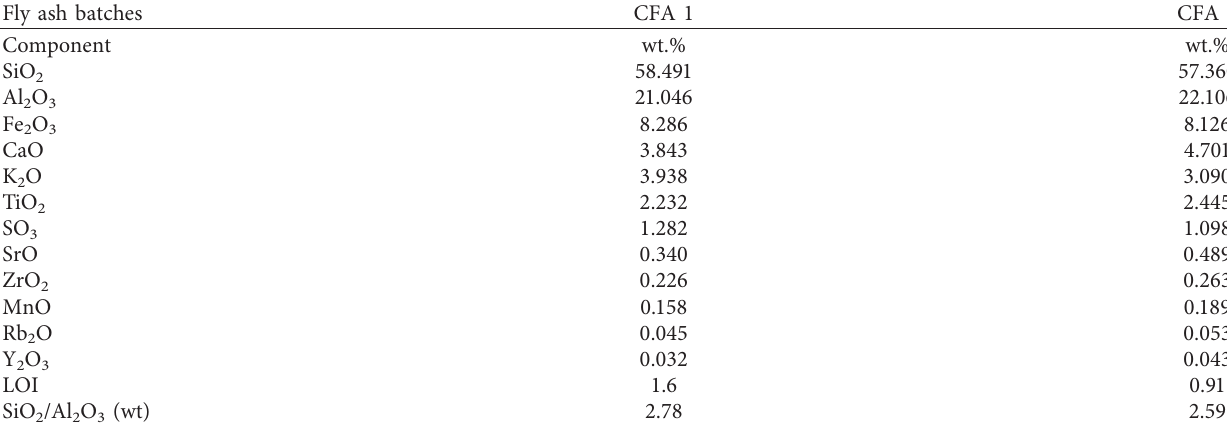
Table 1: Chemical composition of each fly ash sample as determined by XRF (quantitative results). Fly ash batches